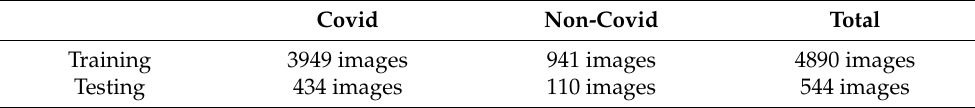
Table 5. The statistics of the symptom dataset.